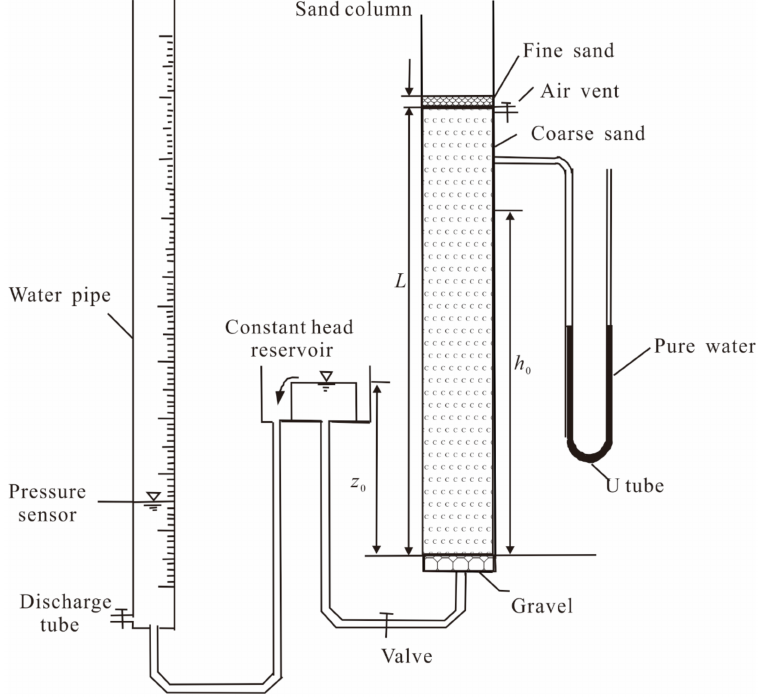
Figure 3. Schematic diagram of setup for the drainage experiment with constant head sources. Modified from Dong et al.